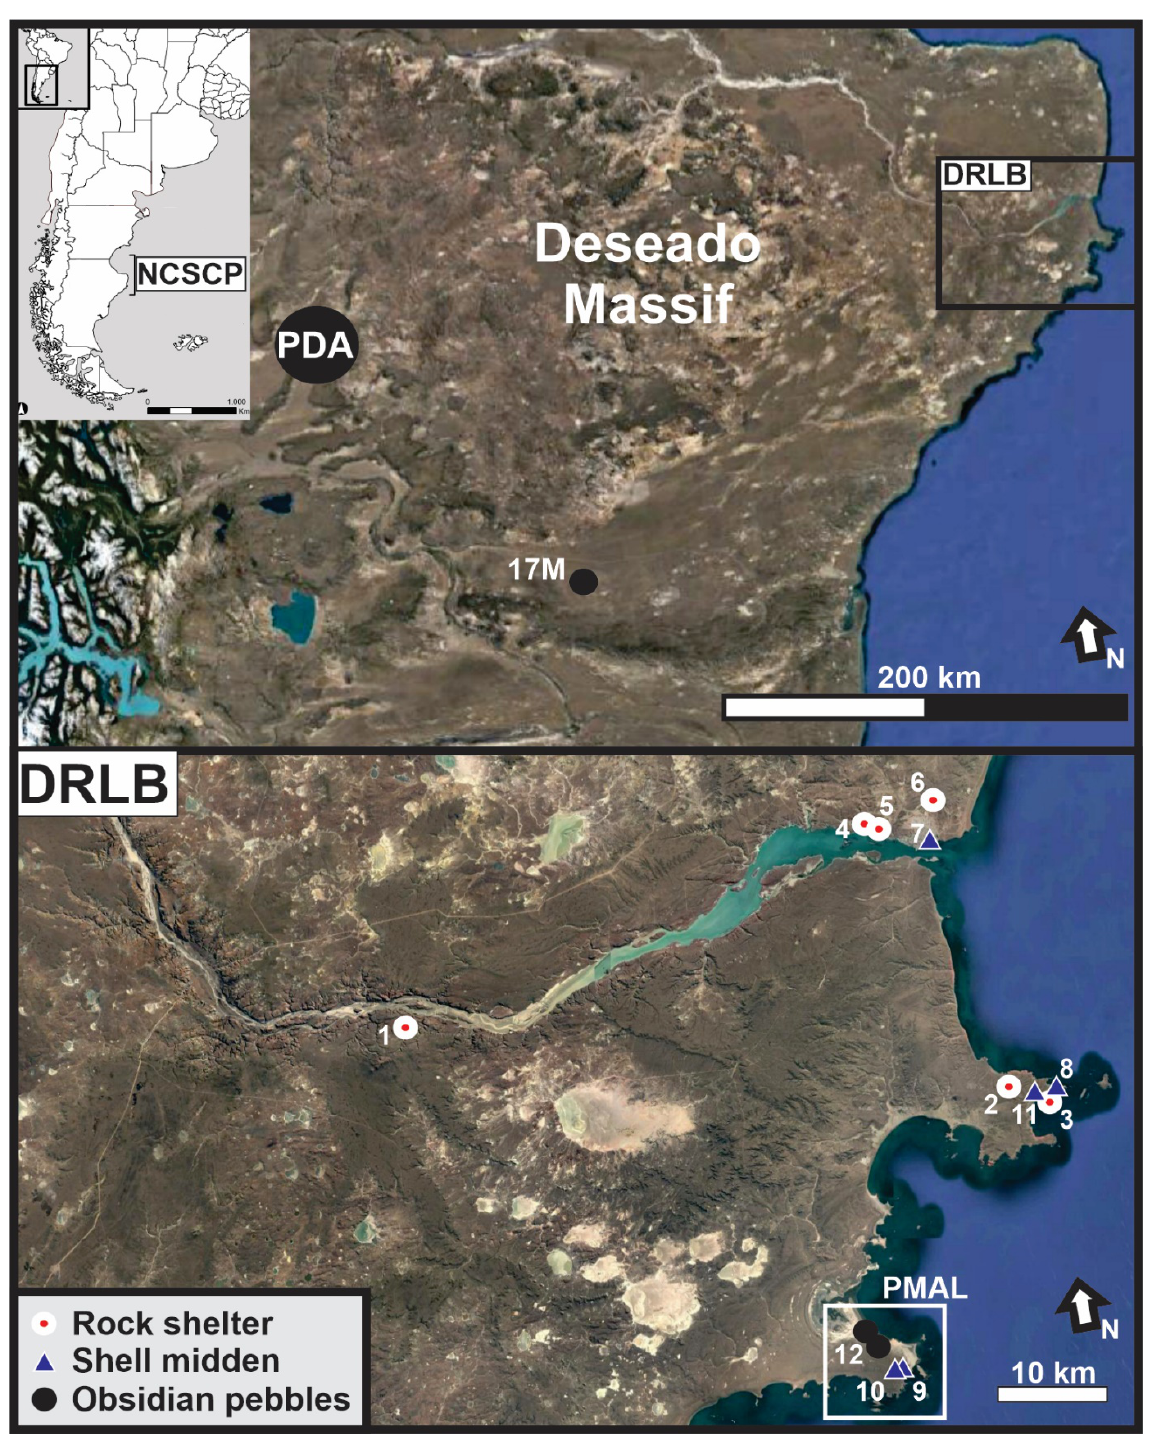
Figure 1. Location of the obsidian sources and archaeological sites containing obsidian. Abbreviations: NCSCP - North Coast of Santa Cruz Province; DRLB - Deseado River Lower Basin; PDA - Pampa del Asador; 17M - 17 de Marzo; PMAL - Punta Medanosa Archaeological Locality; 1 - Cueva Marsicano; 2 - Alero El Oriental; 3